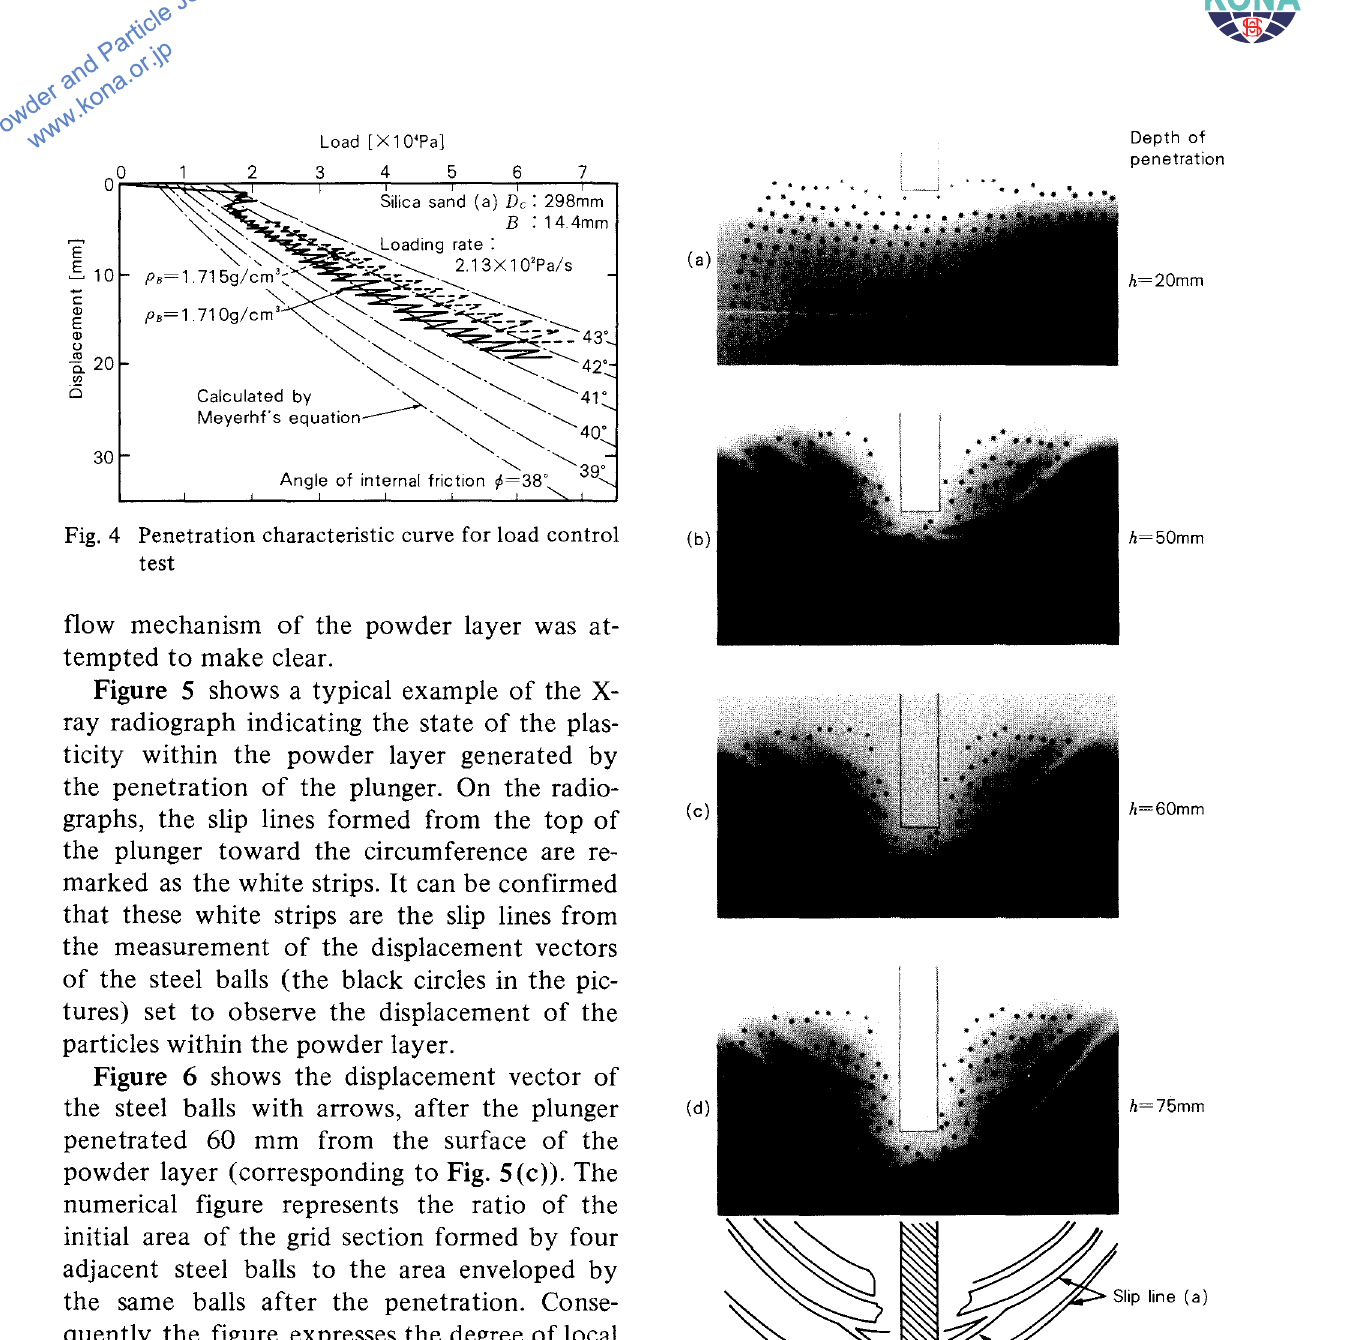
layer. Moreover, paying attention to the slip lines on the left side of the plunger, the dis placement vectors of the particles over the slip line have the clock-wise rotational component to the slip line, while those under the slip line have the counterclock-wise rotational compo nent, even if they are small. As a result, the local large dilatation takes place at the part